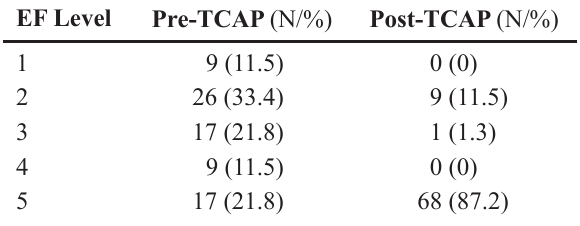
Table 2 – Distribution of pre- and post- targeted cryo- ablation of the prostate (TCAP) erectile function and dysfunction.